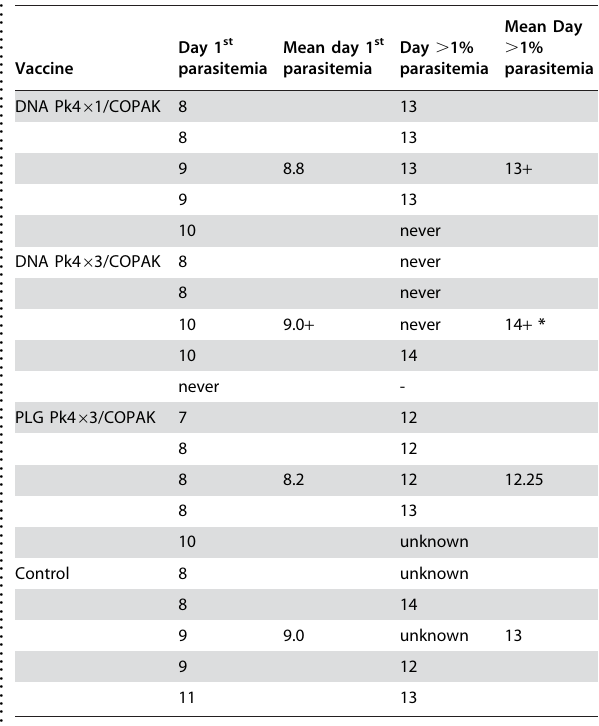
Table 2. Summary of Parasitemia Data in Experiment # 1 .. ... .... ... ... .... ... ... .... ... ... .... ... ... .... ... ... .... ... ... .... .